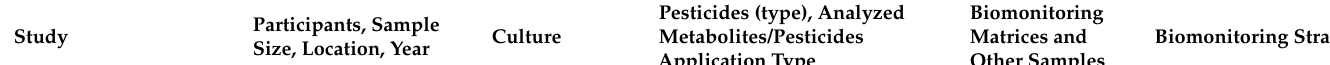
Table 2. Study characteristics of studies on vine as the target